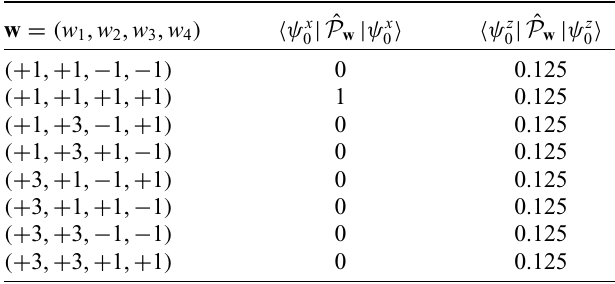
TABLE II. The superselection sectors w of the gauge symme- try generated by ˆ W j , and the expectation values of their projec- tors relative to the initial states of Fig. 2. The gauge-invariant (cid:3) resides within a single superselection sector initial state | ψ x 0 w j = g j = + 1 for all j , while the gauge-noninvariant initial state | ψ z (cid:3) is an equal-weight superposition over various superselec- 0 tion sectors w that are equivalent to the superselection sectors